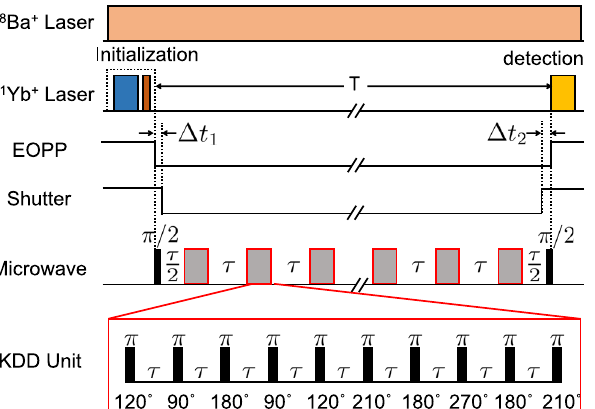
Fig. 2 Experimental sequence. Cooling laser beams for the 138 Ba + ion are applied during the whole sequence. For 171 Yb + ion, we fi rst initialize the qubit and then start to apply the microwave pulses. All the KDD xy (Knill dynamical decoupling) pulses are inserted between two π /2 pulses of Ramsey sequence. Blue and brown blocks represent Doppler cooling and optical pumping pulses for 171 Yb + ion. EOPP and shutter are closed after state initialization and opened before state readout, where the time delays between them are shown as Δ t ≈ 10 ms, which is mainly caused by the limited speed of the mechanical shutter. Gray blocks represent KDD xy units. T is the total measurement time, and τ is the interval of pulses. Each KDD xy unit has ten π pulses, where the fi rst and the second fi ve pulses represent σ σ fi ve pulses have 90° x - and y -rotation, respectively. Therefore, the second phase shift from the fi rst fi ve. We choose the total number of KDD xy units even to make sure all the KDD xy pulses are identity operation in the ideal case. In the end, we use a detection laser pulse to measure the qubit state. Fig. 4 Results of quantum process tomography. a Red and blue points represent process and mean fi delities, respectively. Error bars are standard deviations. The red line is the fi tting result of Eq. (1). The blue line is the fi tting result of the exponential decay function. Inset shows extrapolations of fi ts in a longer time range. The shadow indicates the enlarged area in the fi gure. The red and blue dashed horizontal lines indicate the process fi delity and mean fi delity of the fi nal state, where the system lost all the quantum information. The blue vertical line indicates the time point when mean fi delity decays to 1/ e threshold. ( b ), The real part of the process matrix after a storage time of (i): 4 min, (ii): 8 min, and (iii): 16 min. The largest diagonal element of the process matrix is the identity operation part, χ exp which is the process fi delity F p . (c), State evolution represented in the Bloch sphere after a storage time of (i): 4 min, (ii): 8 min, and (iii): 16 min. Gray meshed spheres represent the initial pure states, which form the Bloch sphere. And blue spheres represent the output states after corresponding storage time, which are the same as the input state at T = 0 but shrink into the Bloch sphere later and transition to a dot in the center for T (cid:3) min ð T ; T Þ . Given the input state, the corresponding output state is 1 2 calculated by the process matrix χ exp Fig. 3 Blue points are from the initial states of 0 j i and 1 j i , and red points are from 0 j i þ 1 j i , 0 j i þ i 1 j i , 0 j i (cid:2) 1 j i , and 0 j i (cid:2) i 1 j i , where ϕ = 0, π , π , 2 and 3 π , respectively. Error bars are standard deviations. Each initial state at 2 each data point repeats 30 to 100 times. The solid lines are the fi tting results by the exponential decay function. Inset shows extrapolations of fi ts in a longer time range. The shadow indicates the enlarged area in the fi gure. The red-dashed line indicates the previous result of superposition states 28 . The black-dashed line indicates the 1/ e threshold. The red and blue arrows indicate times when threshold are reached.